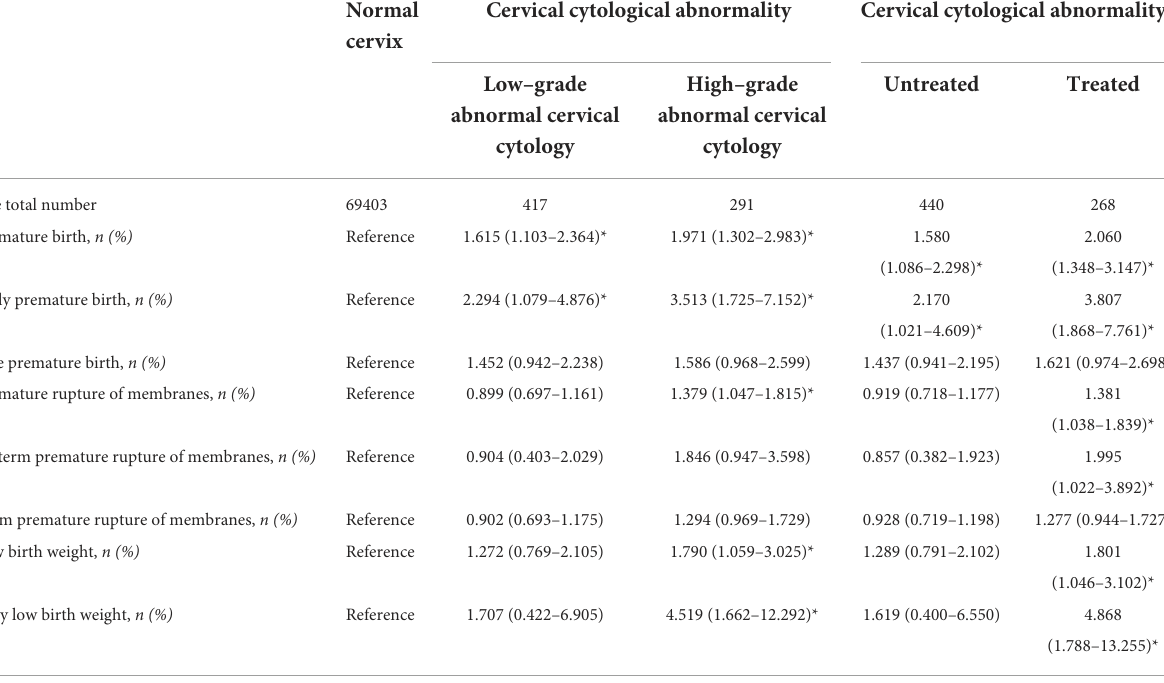
TABLE 4 Adjusted OR (95% CI) for the associations between different classifications of cervical cytological abnormality and adverse